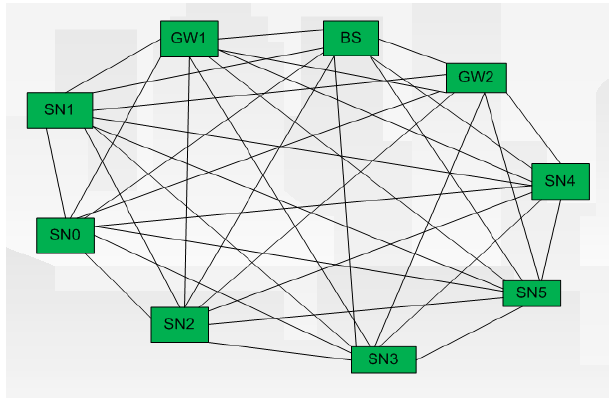
Table 3 Experimental setup for dense topology